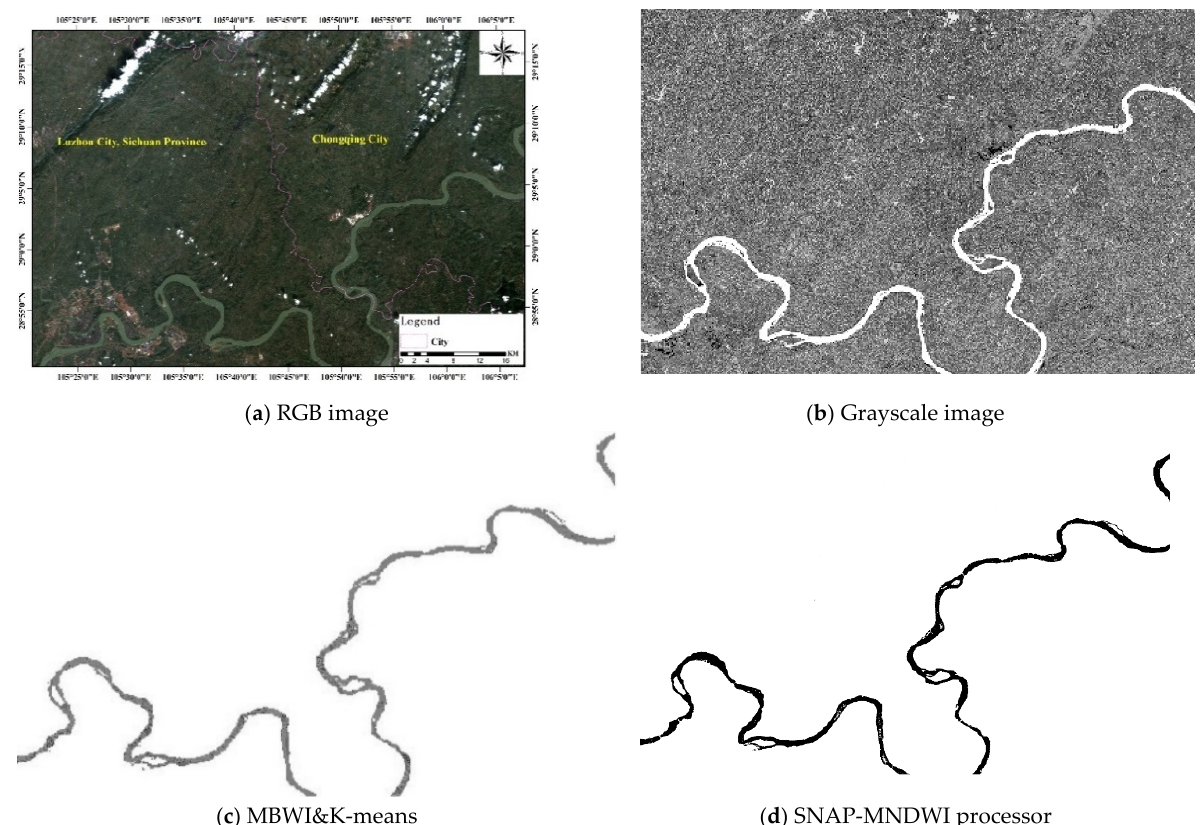
Figure 2. Result of waterbody extraction from Yangtze River: ( a ) RGB image; ( b ) Grayscale image; ( c ) MBWI&K-means; ( d ) SNAP-MNDWI processor.